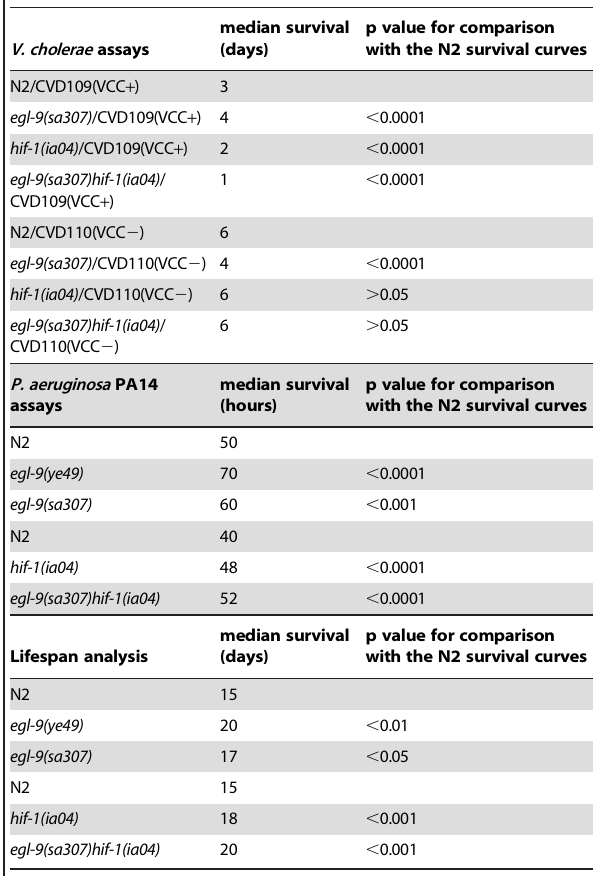
Table 2. Data and analyses of VCC, PA14, and lifespan